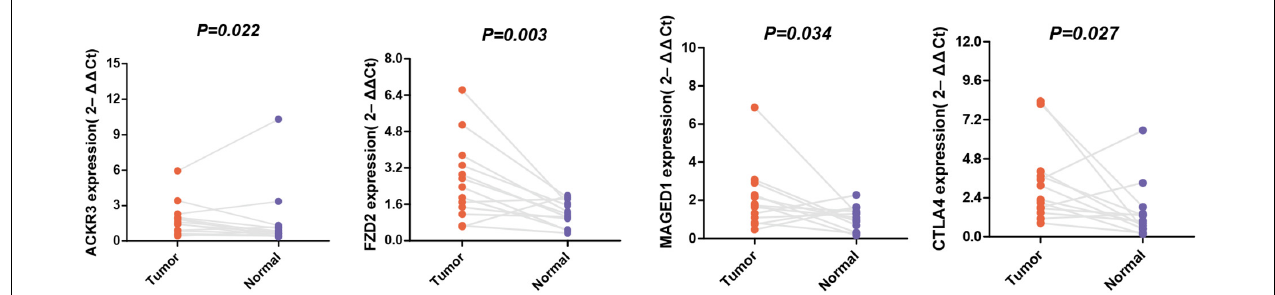
FIGURE 7 | The mRNA expression of MAGED1, ACKR3, FZD2, and CTLA4 in a GC tumor and the adjacent